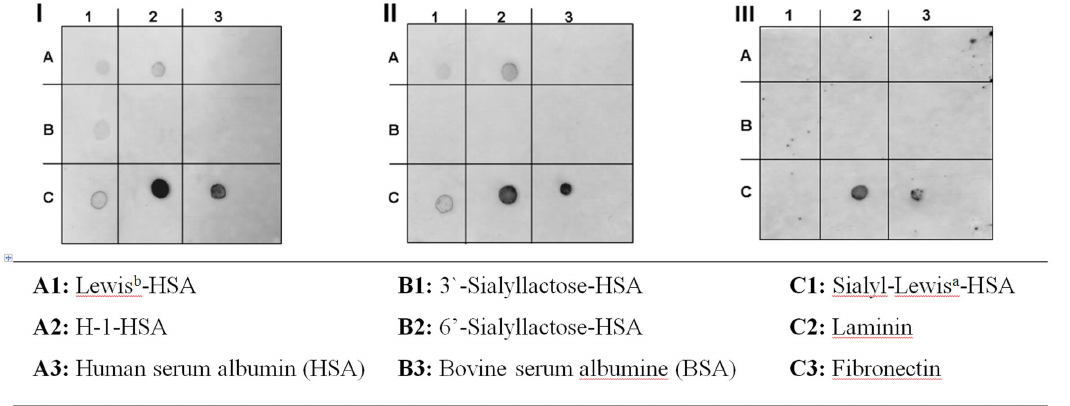
Figure 2. Representative images of the adhesion of FITC-labeled H.pylori wild-type strain J99 to immobilized ligands on PVDF membranes. ( I ) untreated control and pretreated bacteria with ( II ) 3 9 -sialyllactose and ( III ) Okra FE. (Neo)glycoproteins spotted on PVDF membranes (1 m g per spot) were overlaid with FITC-labeled H. pylori and adherent bacteria were detected by fluorescence imaging. The respective locations of spotted (neo)glycoproteins are indicated below.